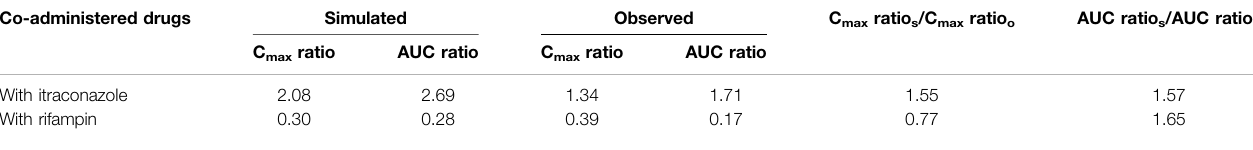
TABLE 4 | Comparison of model-predicted C max and AUC to the observed one in the presence or the absence of inhibitor or inducer Co-administered